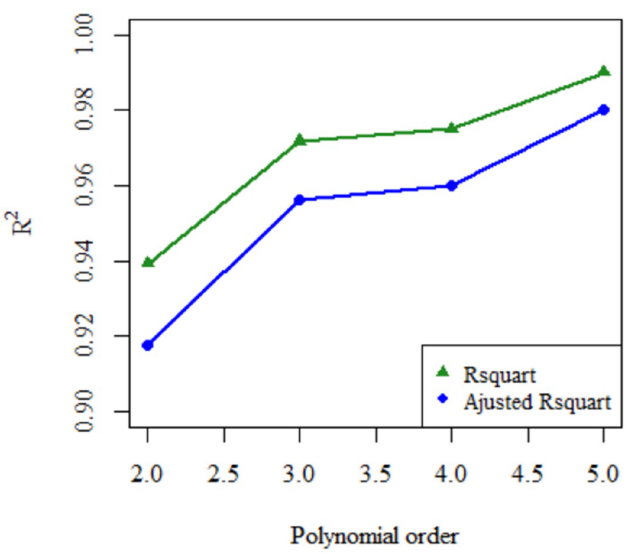
Fig 4. Average of R 2 —R 2 a of the data sets fitted to the second to fifth order polynomials.